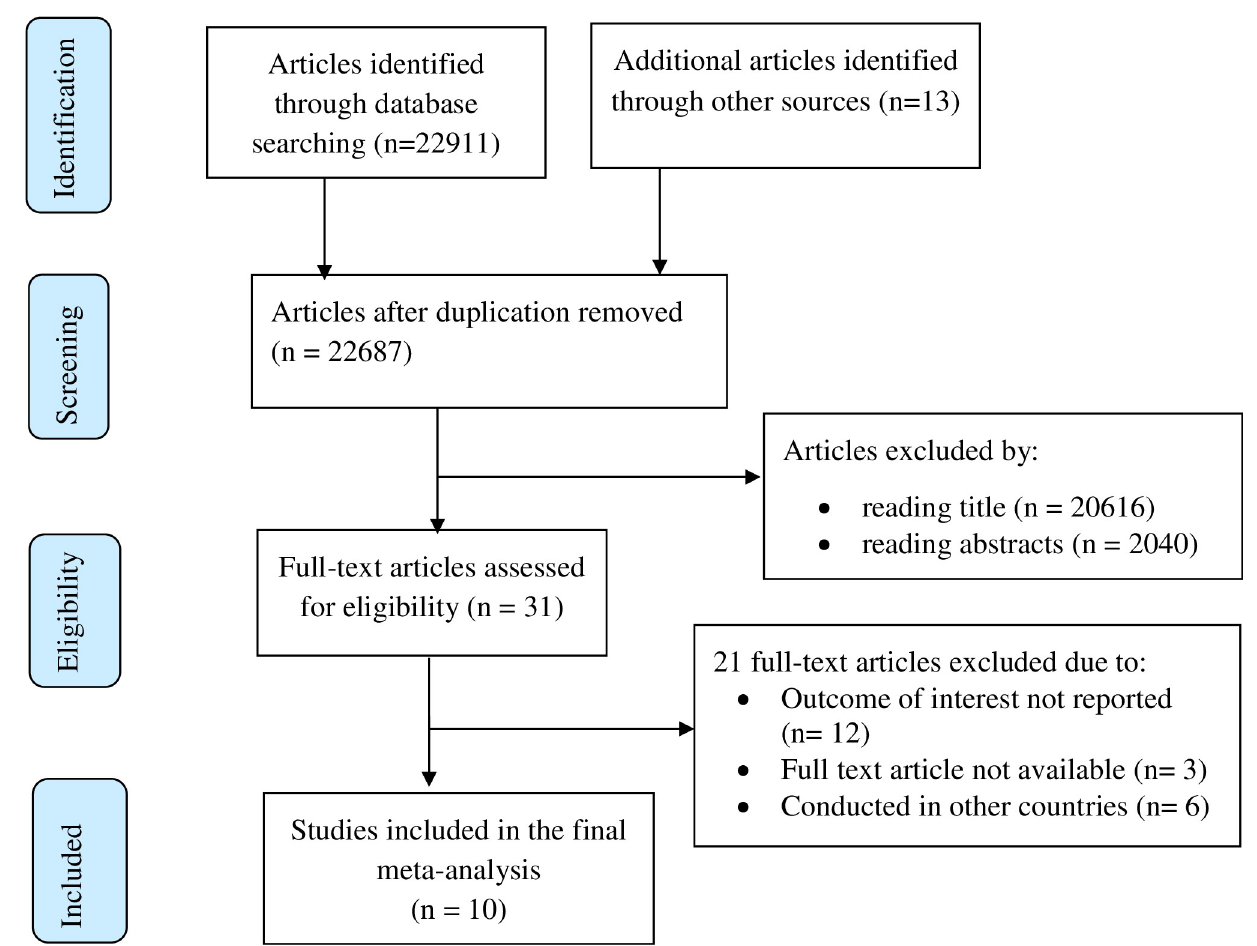
Fig 1. Flow chart of study selection for systematic review and meta-analysis of utilization of routine health information and associated factors among health workers in Ethiopia, 2020.